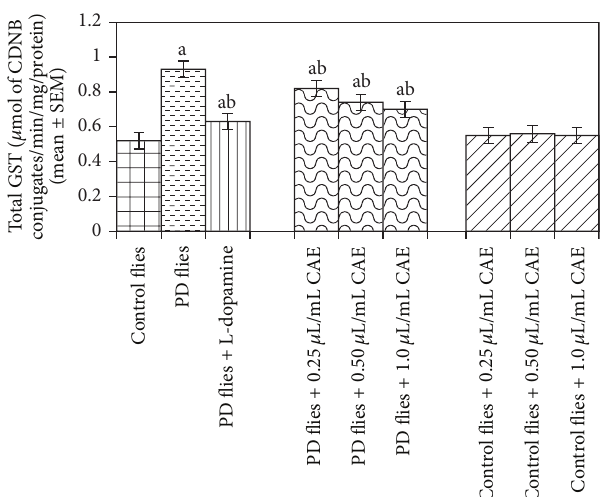
Figure 17: Effect of Centella asiatica extract (CAE) on glutathione- S-transferase (GST) content measured in the brains of transgenic Drosophila melanogaster after 24 days of the exposure to vari- ous treated groups ( a significant with respect to control, 𝑃 -0.01; b significant with respect to PD model flies, 𝑃 -0.05). L-Dopa = 10 −3 M; control flies: UAS-alpha-syn; PD flies: elav-GAL4; UAS-